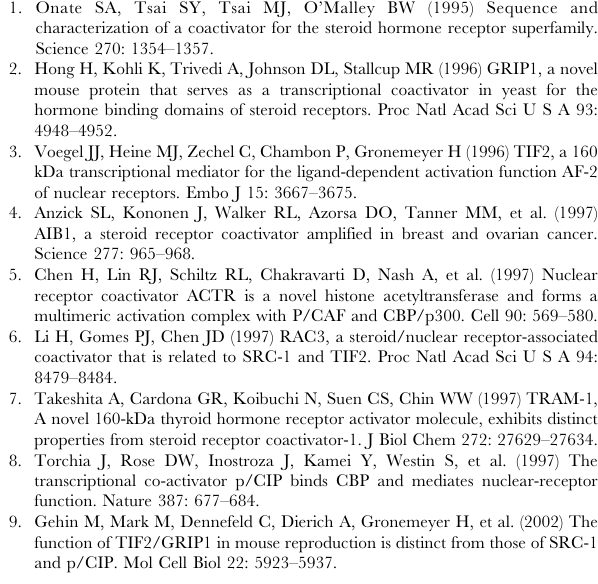
Table S1 Primer sequences used for Q-rt-PCR. (DOC) Table S2 Downregulated differentially expressed genes induced by SRC-2 shRNA. FC $ 1.5, q-value = 0. Table S3 Upregulated differentially expressed genes induced by SRC-2 shRNA. FC $ 1.5, q-value = 0. Table S4 Downregulated differentially expressed genes induced by cAMP. FC $ 1.5, q-value = 0. (XLSX) Table S5 Upregulated differentially expressed genes induced by cAMP. FC $ 1.5, q-value = 0. (XLSX) Table S6 Overlapping downregulated differentially ex- pressed genes induced by SRC-2 shRNA and cAMP. FC